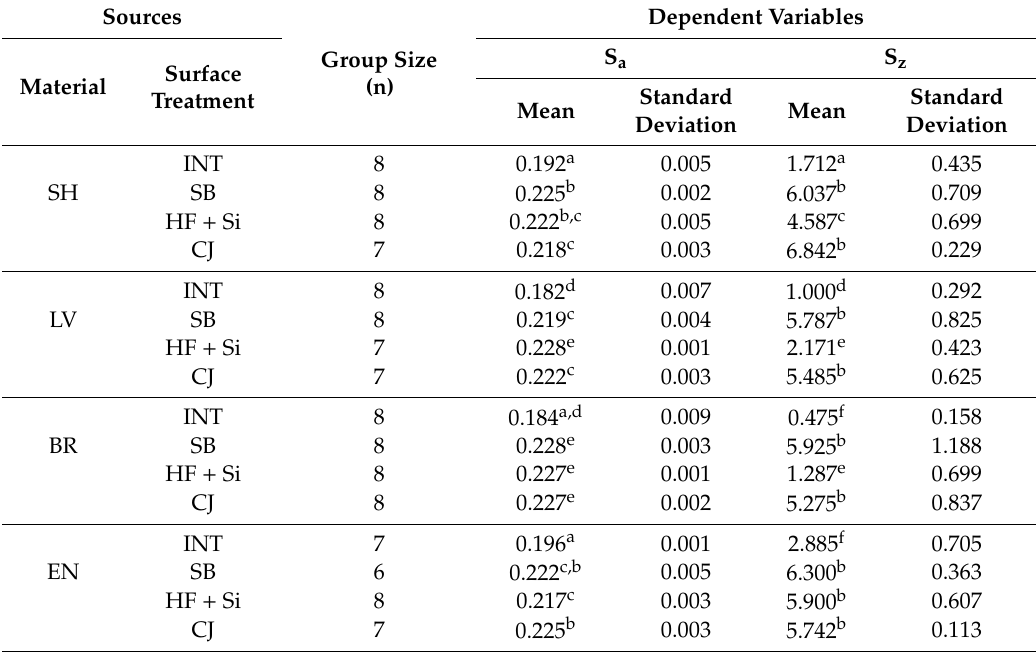
Table 2. Means and standard deviations of S a ( µ m) and S z ( µ m) with respect to material and surface treatment. The same lowercase superscripts in columns indicate no statistically significant di ff erence ( p > 0.05).